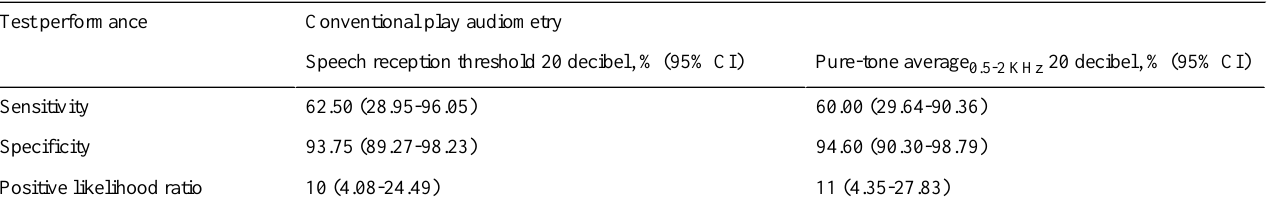
Table 2. The sensitivity and specificity of Preschool Audiometry Screening System speech audiometry app version 1 compared with that of Conventional Play Audiometry.